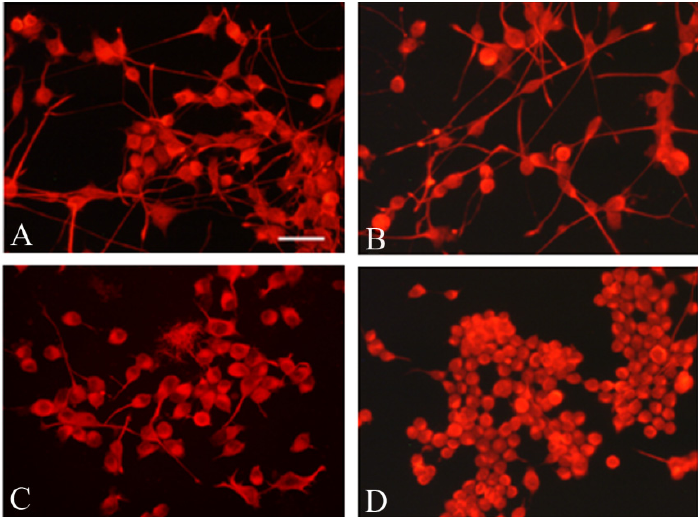
Figure 6. Morphology of NSC34 ( A ); Mock ( B ); shRNA 70% ( C ) and shRNA 40% ( D ) induced to differentiate for six d.i.v. The neuronal soma and axonal processes were immunostained with an antibody against the neurofilament heavy chain subunit (NF-H). Bar = 50 μ